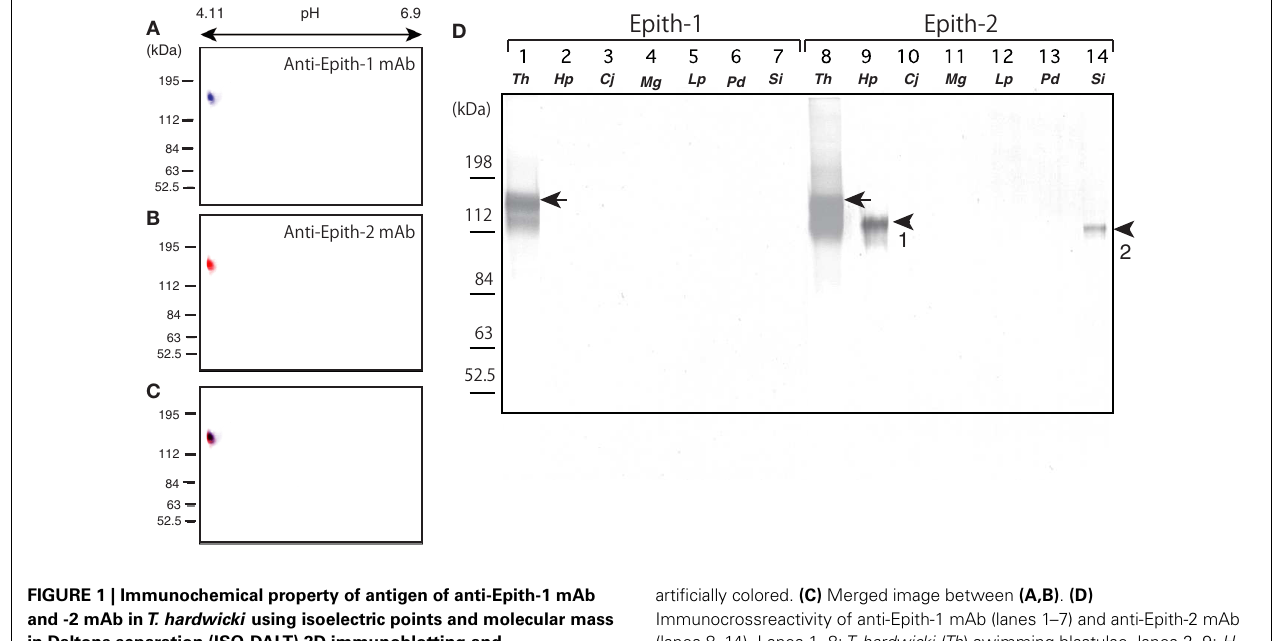
FIGURE 1 | Immunochemical property of antigen of anti-Epith-1 mAb and -2 mAb in T. hardwicki using isoelectric points and molecular mass in Daltons separation (ISO-DALT) 2D immunoblotting and immunocrossreactivity of these two mAbs among seven species of sea urchins . (A) ISO-DALT 2D immunoblotting with anti-Epith-1 mAb shows an immunopositive spot at 160kDa region and pH 4.98 (blue).The spot was artificially colored. (B) ISO-DALT 2D immunoblotting with anti-Epith-2 mAb shows an immunopositive spot (red) at the same region as (A) .The spot was